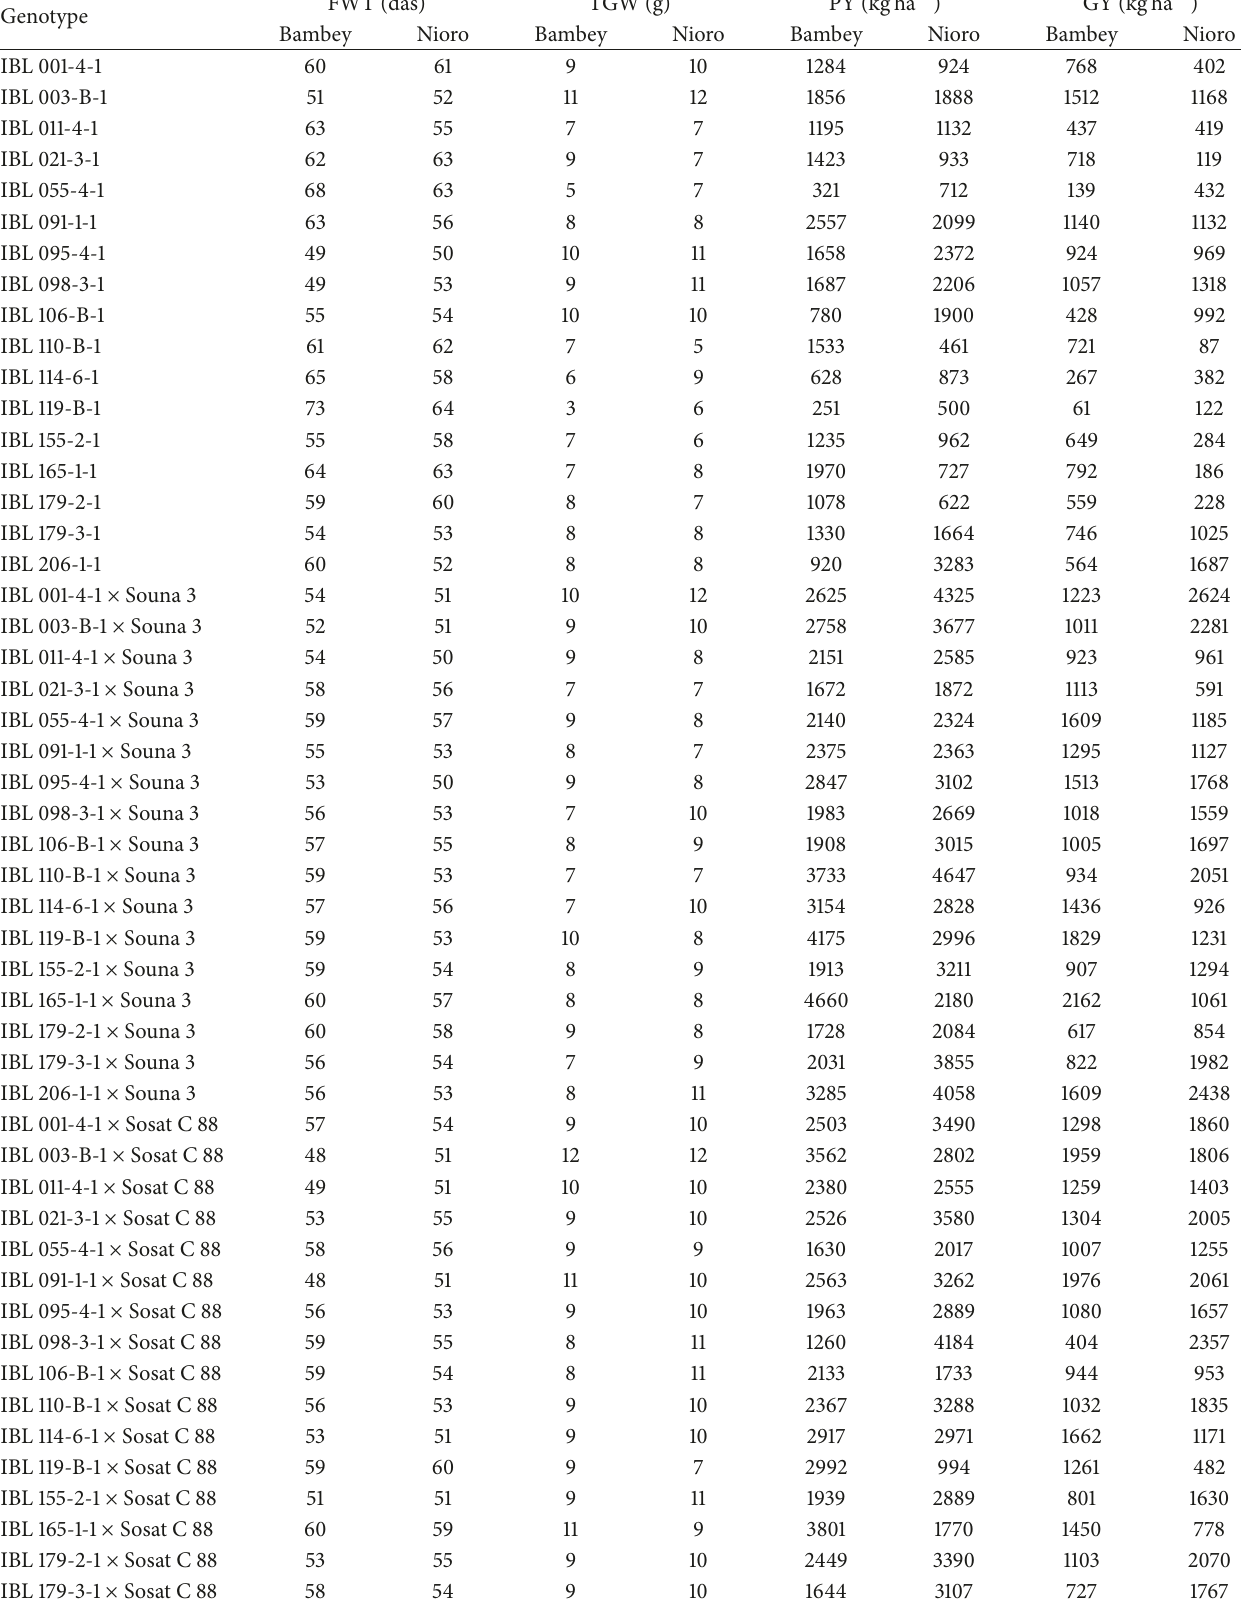
Table 4: Mean flowering time, yield, and related traits of genotypes per